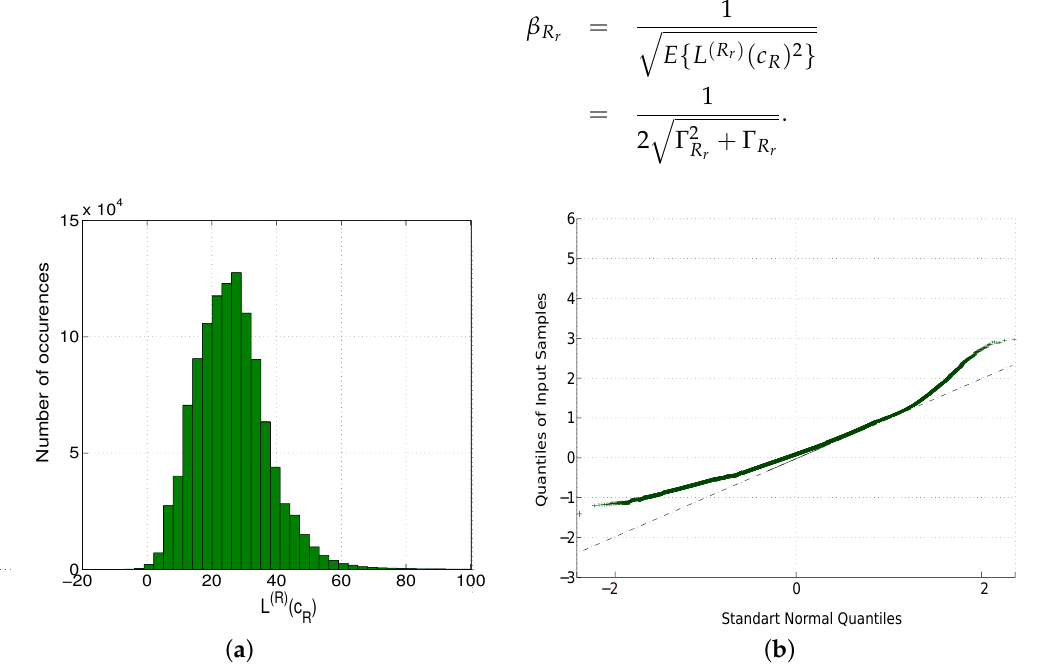
Figure 2. ( a ) Histogram of a relay soft encoder output LLRs for E b / N 0 = 10 dB, ( b ) normal Q-Q plot of the distribution (green line) and y = x line (dashed